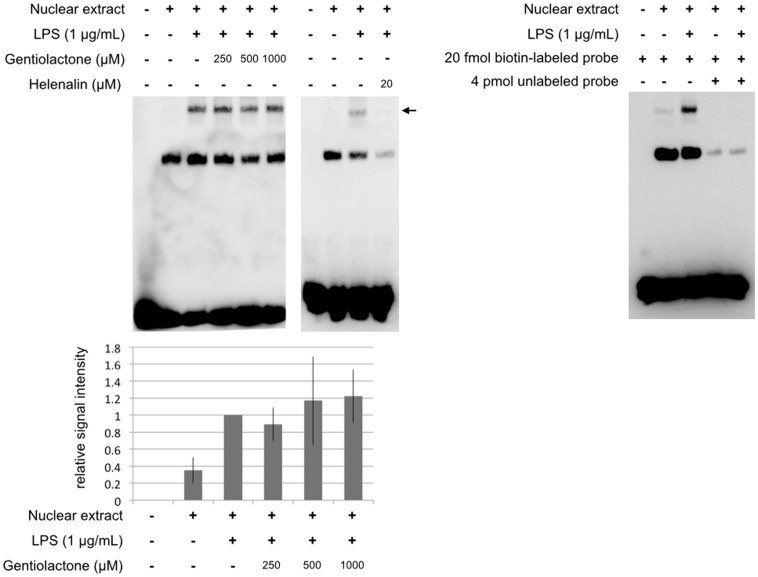
Gentiolactone does not inhibit DNA binding of NF-κB.RAW264.7 cells were cultured for 1 hour with LPS (1 µg/mL) and gentiolactone (250, 500, 1000 µM). Nuclear proteins were extracted and incubated with biotinylated oligonucleotides containing a binding site for NF-κB. Resultant complexes were analyzed by EMSA. The bands indicated by the arrow were quantified. Plotted values represent the mean value ± SD from three independent cultures. Helenalin was used as a positive control.